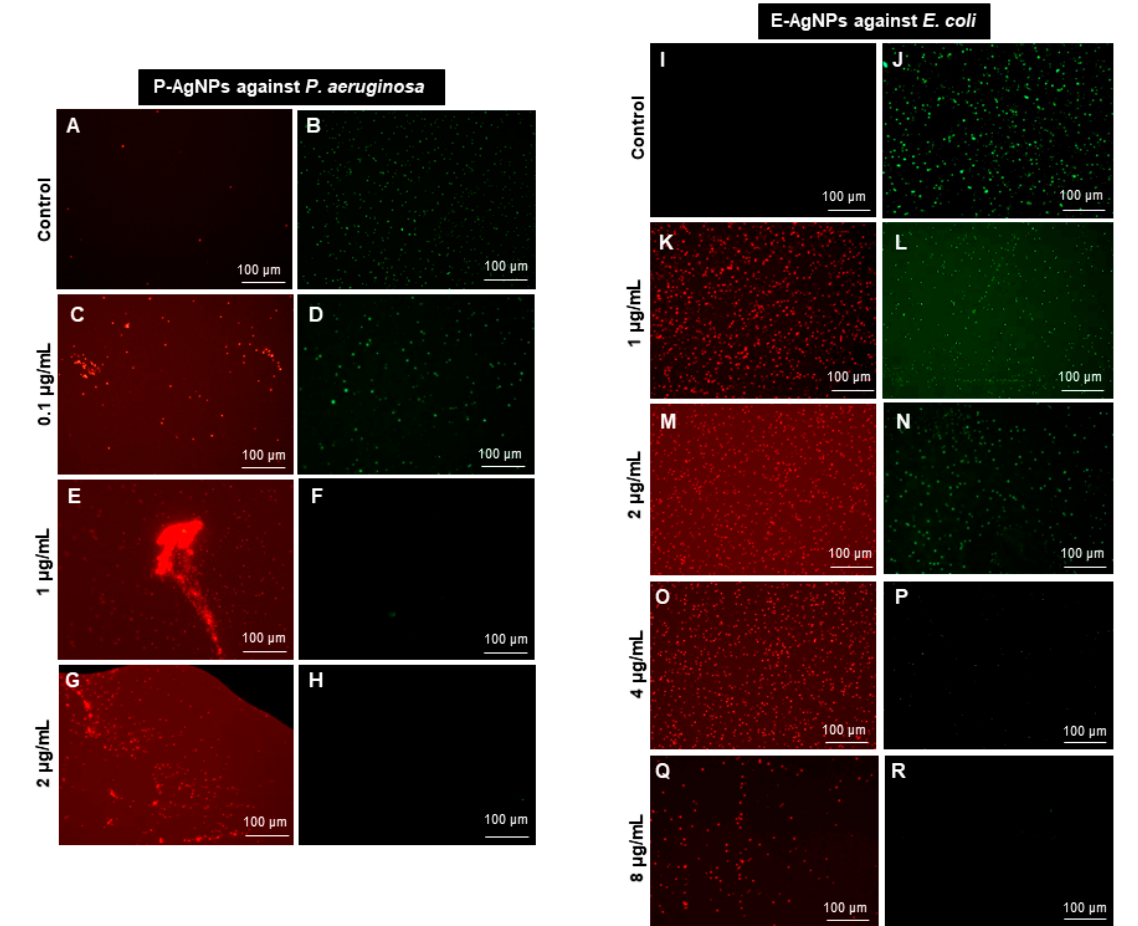
Figure 11. Live and dead staining. ( A – H ) P-AgNPs effects on P. aeruginosa and ( I – R ) E-AgNPs effects on E. coli.